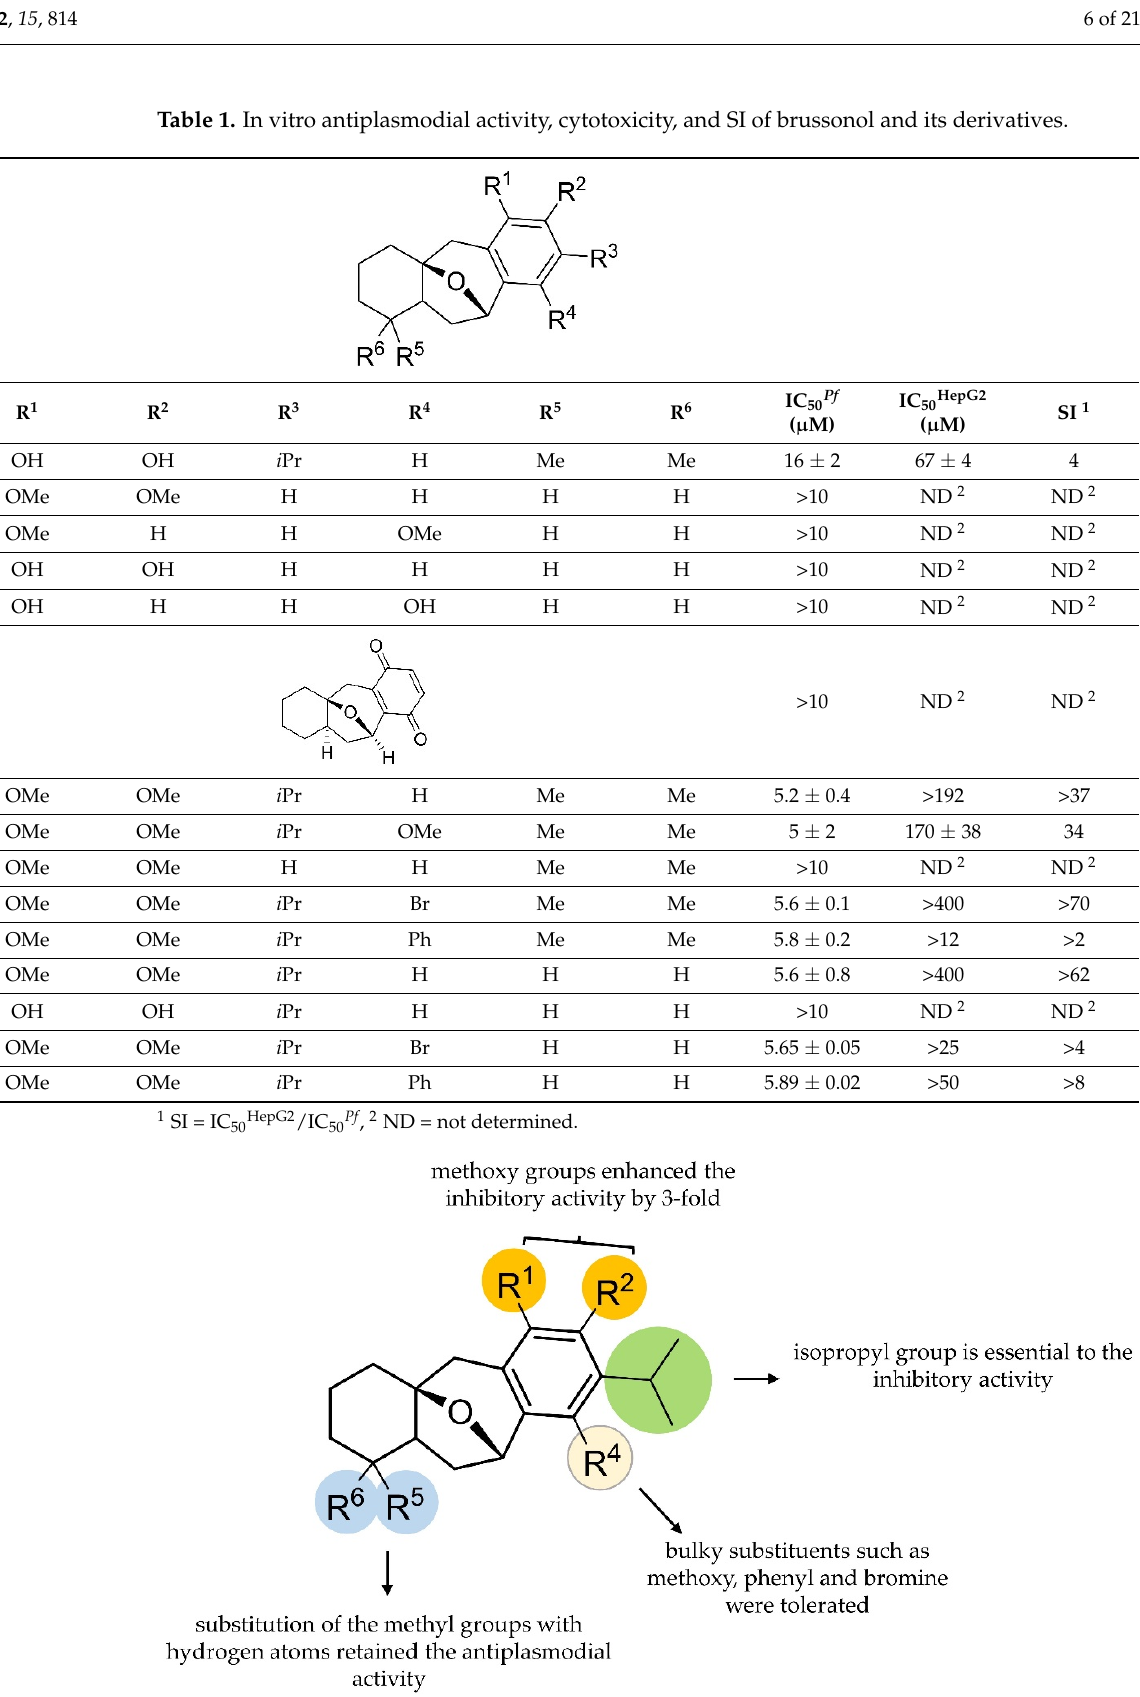
human hepatocellular carcinoma (HepG2) cell line. Brussonol and derivatives